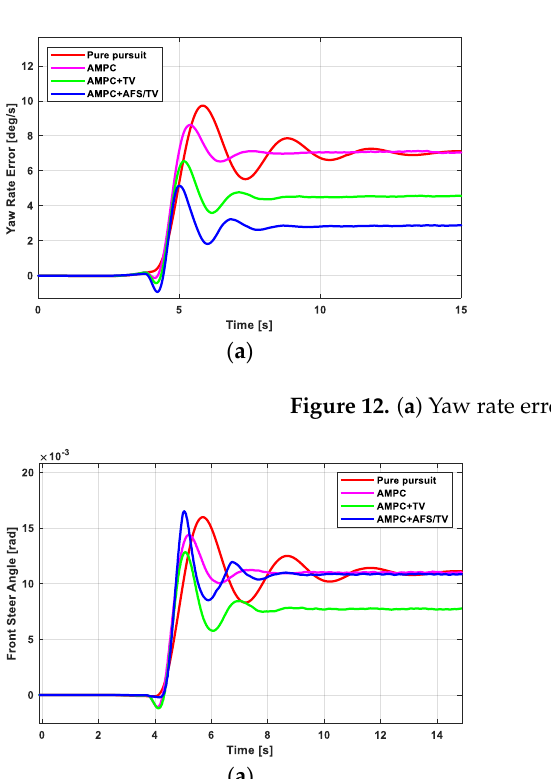
( b ) Figure 11. ( a ) Vehicle trajectory and ( b ) lateral error.